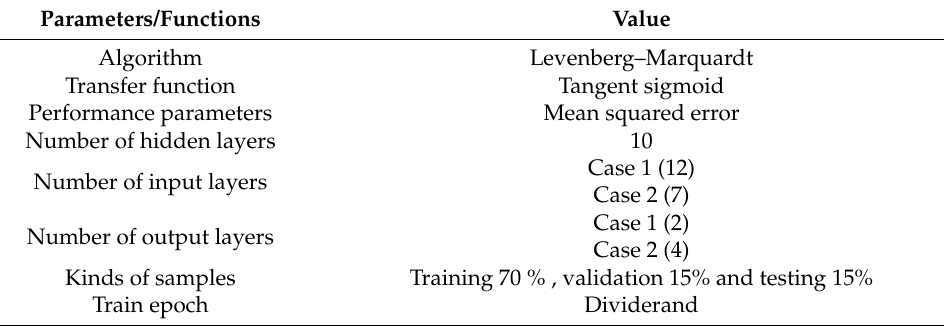
Figure 4. Structure of the ANN models for ( a ) Case 1 and ( b ) Case 2. Table 4. Basic settings of the ANN